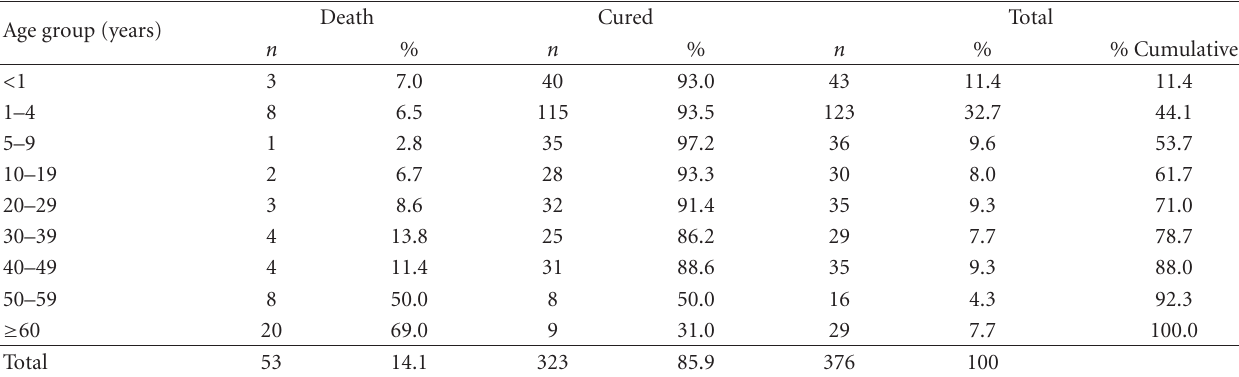
Table 1: Visceral leishmaniasis-confirmed autochthonous cases, by age group and clinical outcome, state of Sao Paulo, 1999–2005. Age group (years)